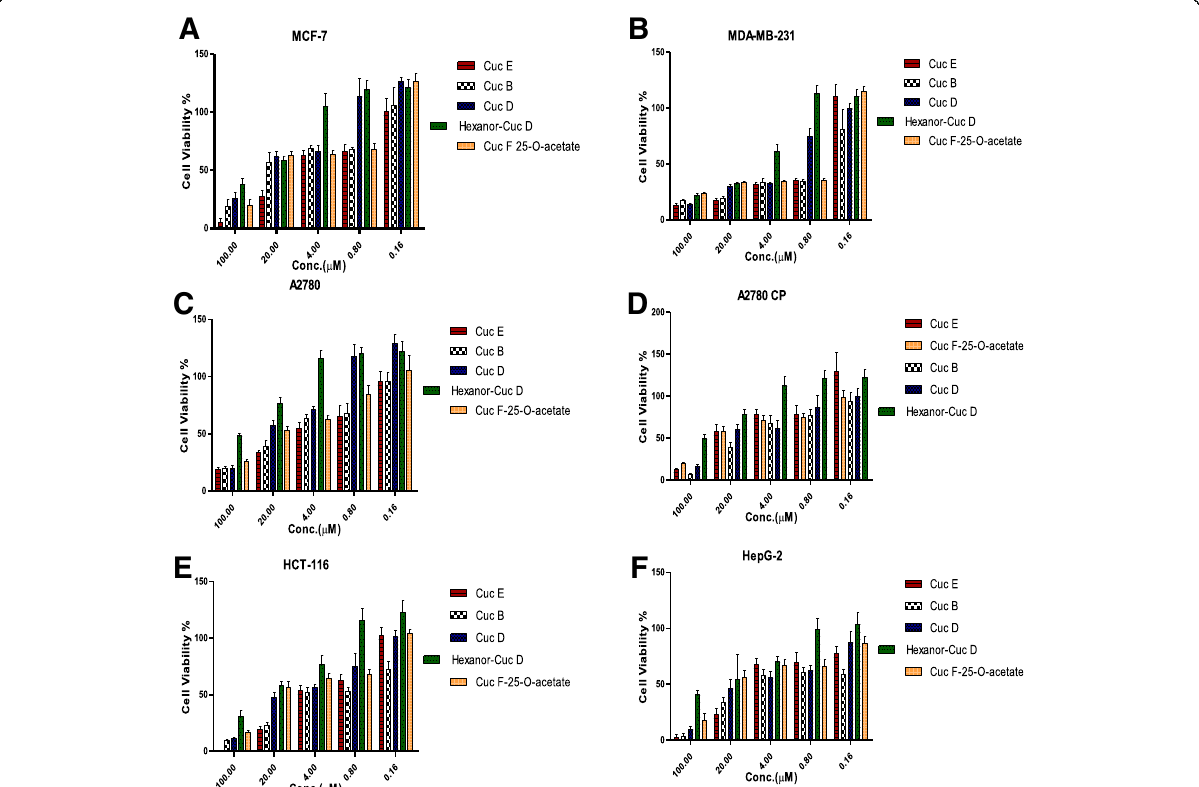
Fig. 4 Inhibitory effects of Cucurbitacins e , b , d , f 25-O-acetate and hexanorcucurbitacin D on proliferation of cancer cells ( a -MCF-7; b -MDA-MB- 231; c -A2780; d -A2780CP; e -HCT-116 and f -HepG2). Cells were treated with 0-100 µM of each compound. MTT assay was used to measure the cell viability % after 48 hrs of treatment. The error bars indicate SD of n = 8 per